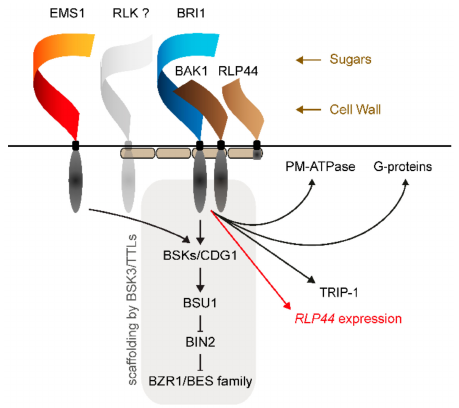
Figure 1. Schematic overview of the brassinosteroid (BR) signalling pathway highlighting newly discovered inputs and outputs. BRASSINOSTEROID INSENSITIVE1 (BRI1) and